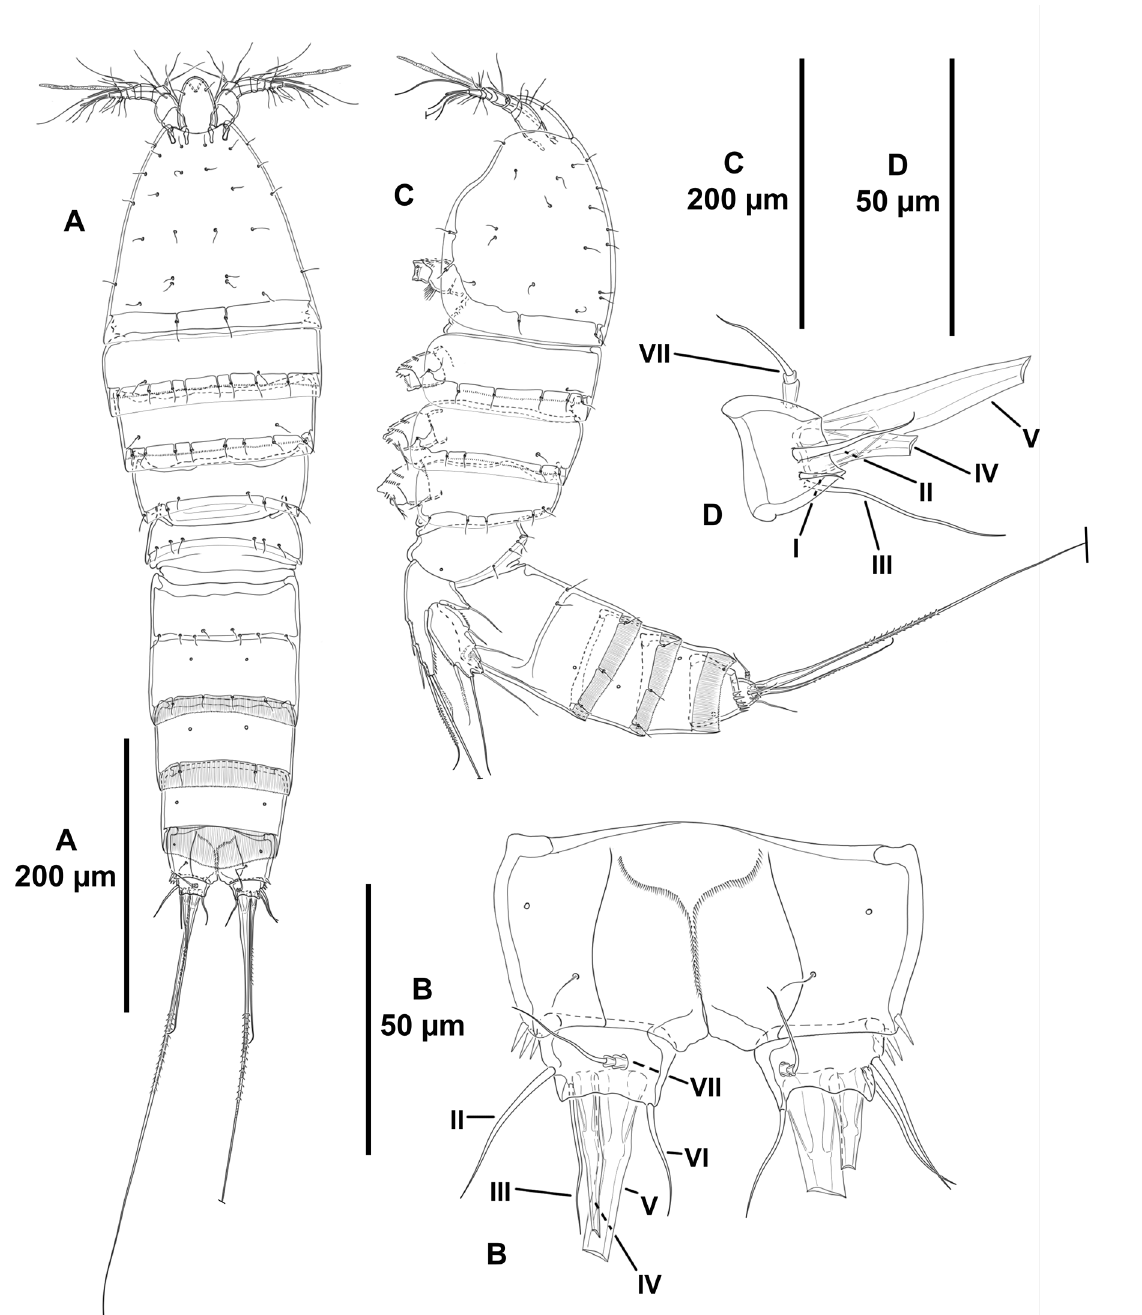
Fig. 11. Spinodiosaccus primus gen. et sp. nov., holotype, ♀ (ICML-EMUCOP-180119-57). A . Habitus, dorsal view. B . Anal somite and caudal rami, dorsal view. C . Habitus, lateral view. D . Left caudal ramus, lateral